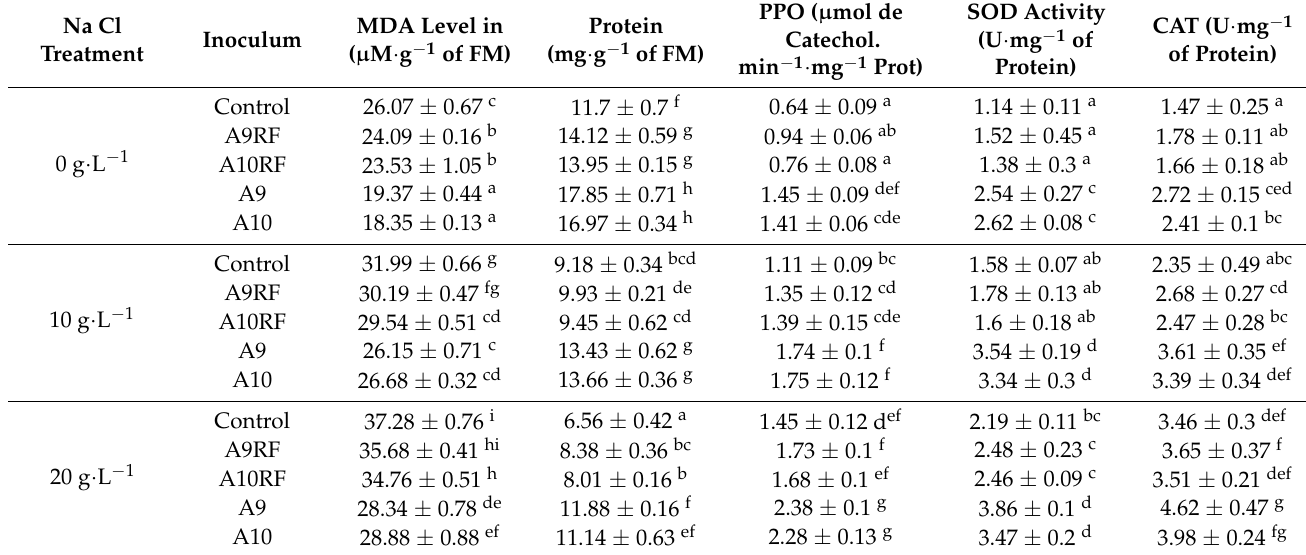
Table 3. Influence of different salinity levels (0 g · L − 1 , 10 g · L − 1 , and 20 g · L − 1 ) and different mycorrhizal inocula on MDA, protein, and oxidative enzyme activity (SOD), (CAT), (PPO) in non-inoculated (control) and inoculated ten-month aged seedlings. The values represented by the same letter did not significantly differ according to Tukey’s test (HSD) ( p < 0.05). Na Cl